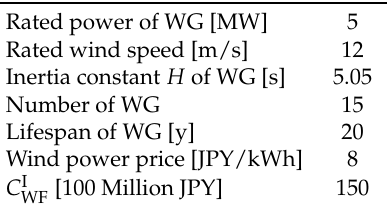
Table 3. Analysis condition.